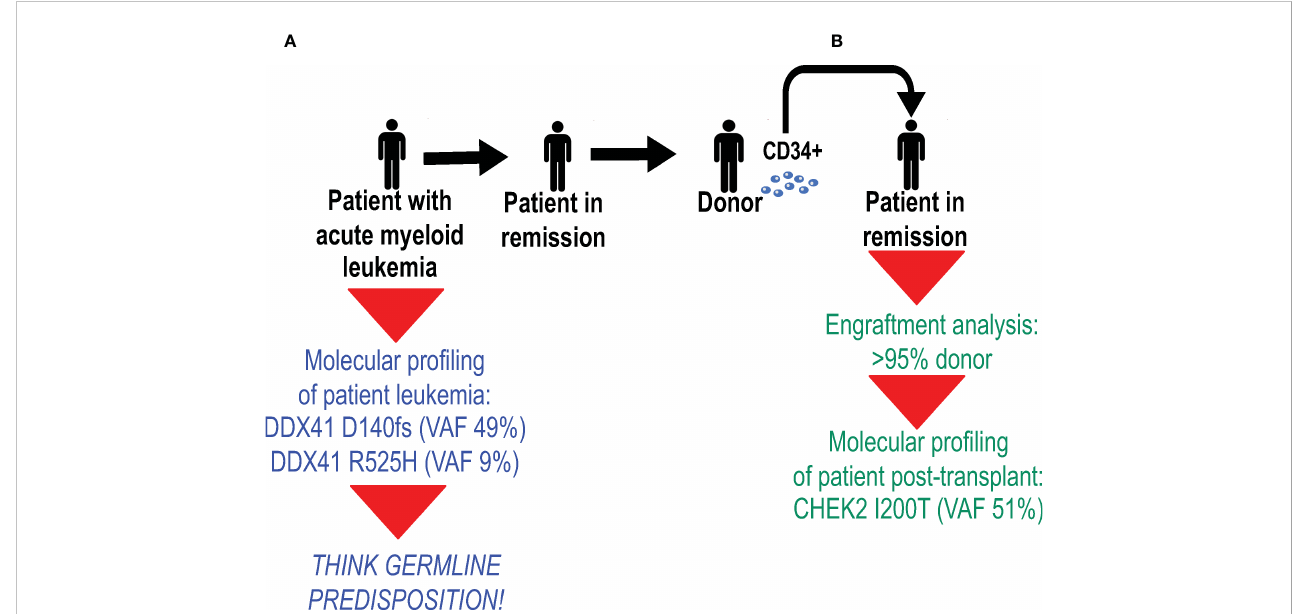
FIGURE 3 Molecular pro fi ling has the capacity to identify donor-derived germline variants after allogeneic hematopoietic stem cell transplantation (HSCT). (A) Molecular pro fi ling of a patient with acute myeloid leukemia revealed two deleterious DDX41 variants (shown in blue): the D140fs variant at a variant allele frequency (VAF) of 49%, and the R525H variant at a VAF of 9%. Because the D140fs variant has always been seen as a germline variant (Table 2), the patient had proper germline testing, which con fi rmed its germline status. (B) After allogeneic HSCT from an unrelated donor, a day 30 bone marrow biopsy was performed. Studies performed on bone marrow cells (shown in green) included engraftment analysis, which showed that >95% of bone marrow cells were donor- derived, and molecular pro fi ling identi fi ed the CHEK2 I200T variant at a VAF of